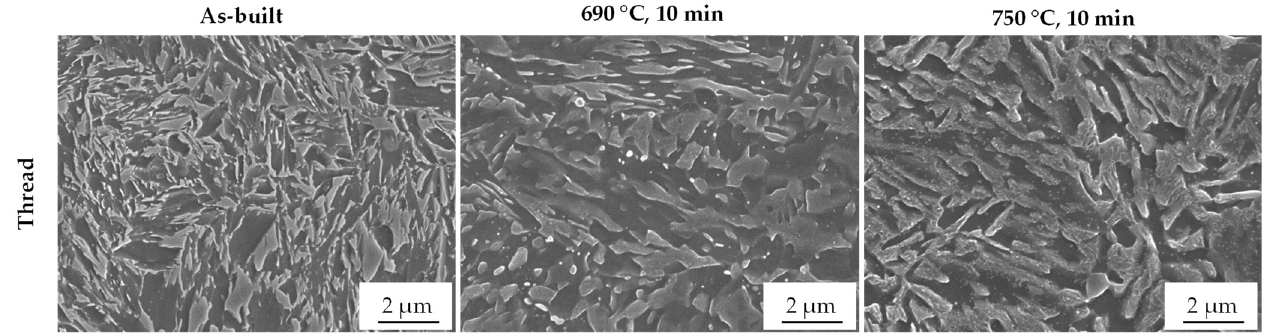
Figure 6. SEM images within the thread region as-built and after intercritical annealing at 690 °C and at 750 °C for 10 min.